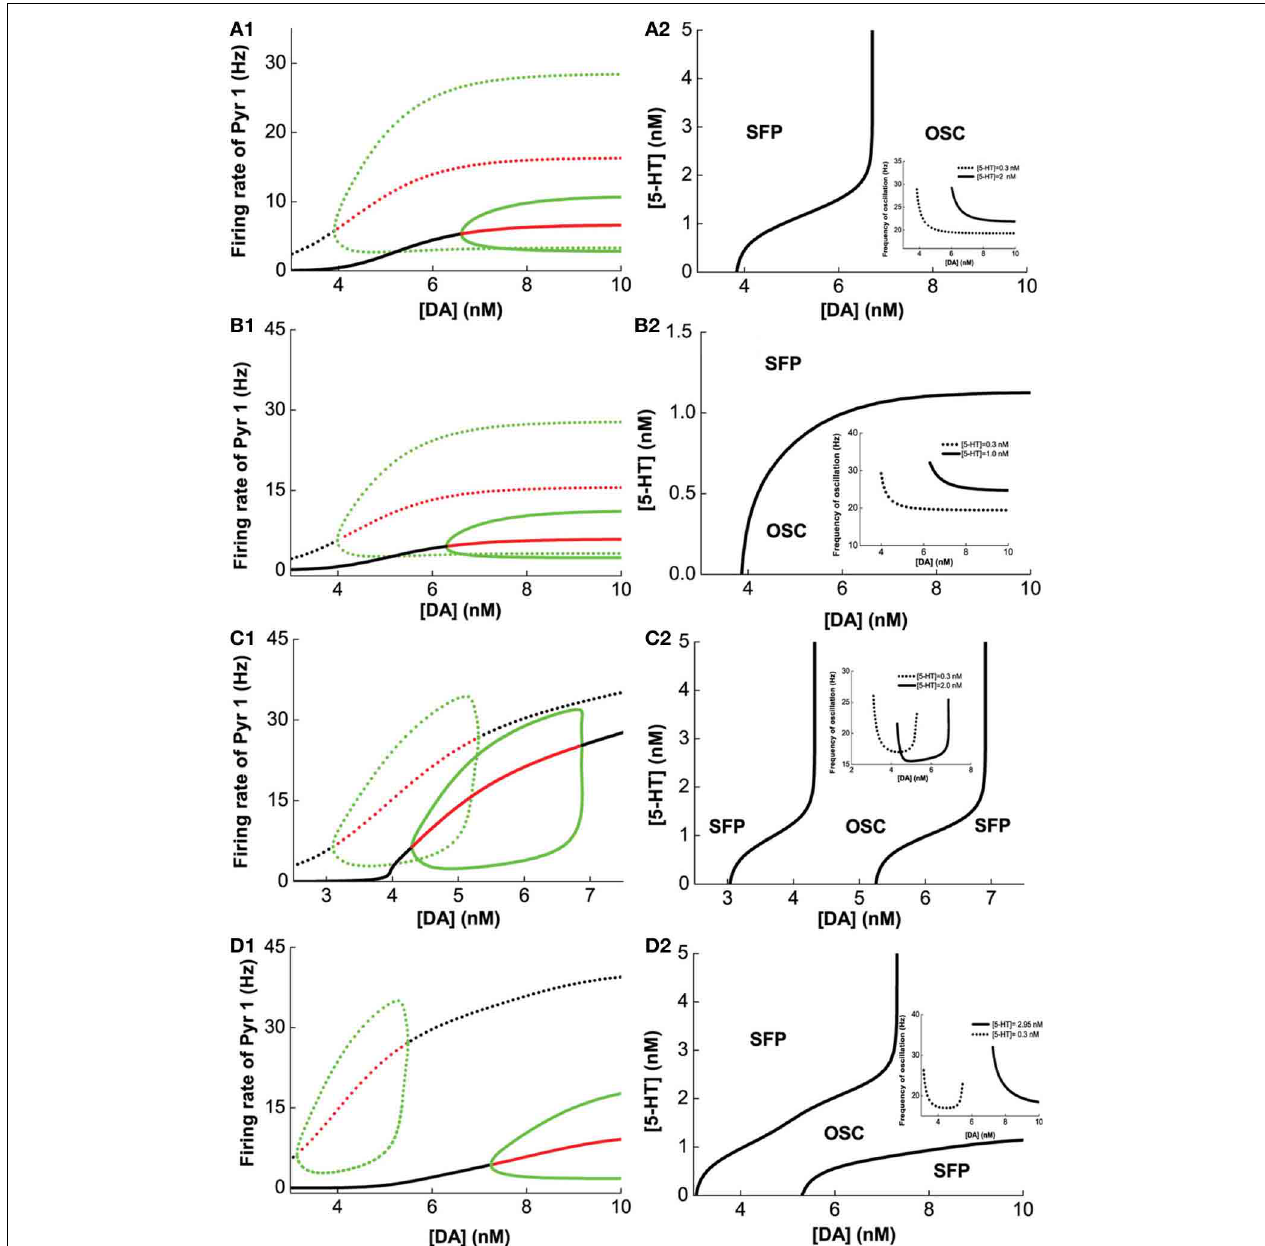
FIGURE 5 | Modulation of [DA] and [5- HT ] on excitatory-inhibitory neuronal networks. Pyr1 (D1 + 5-HT1A) neurons paired with: (A) Int1 (D1 + 5-1HT1A), (B) Int2 (D1 + 5-HT2A), (C) Int3 (D2 + 5-HT1A), (D) Int4 (D2 + 5-HT2A) neurons. Left: Stability or bifurcation diagrams with respect to [DA] given [5- HT ] = 0.3nM (dotted) or 2, 1, 2,and 2 . 95nM 1(solid) for (A–D) ,